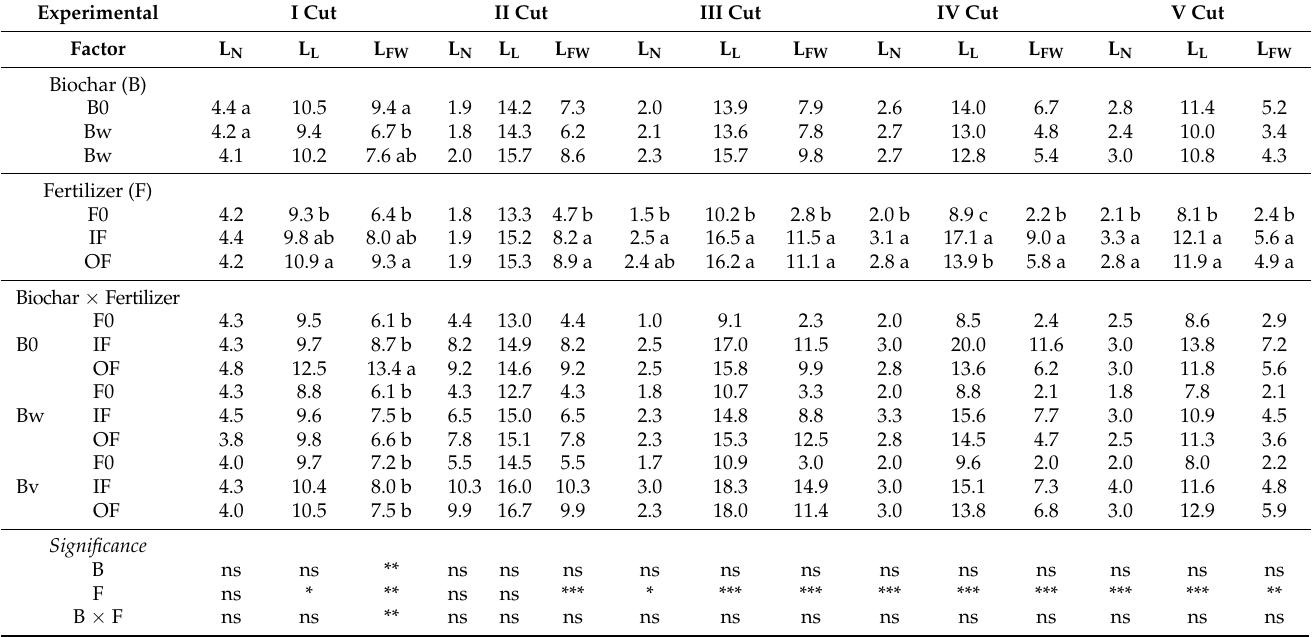
Table 5. Leaf number (L N , n ◦ ), length (L L , cm) and fresh weight (L FW , g), at the five leaf cuts performed during the growing cycle of Swiss